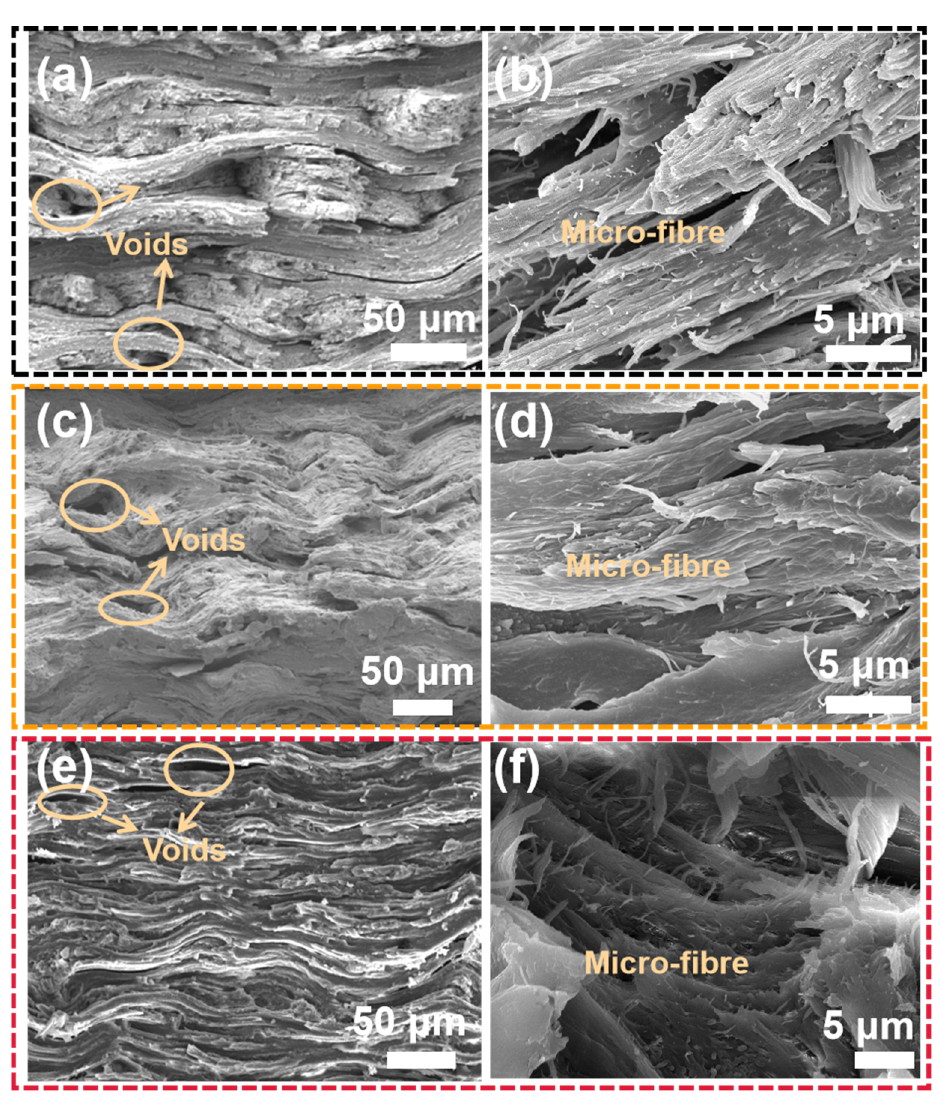
Figure 7. SEM images of brittle fracture with liquid nitrogen of the three Caprinae horn sheaths: ( a , b ) Cg ‐ hs; ( c , d ) Wg ‐ hs; ( e , f ) Bs ‐ hs. ( a , b ) Cg-hs; ( c , d ) Wg-hs; ( e , f )